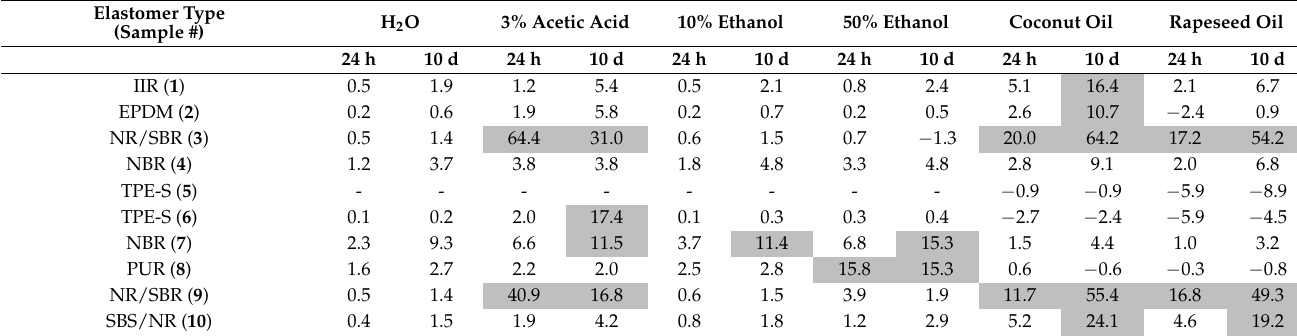
Table 4. Swelling of elastomer samples in food simulants in % as determined by weight gain after 24 h and 10 days of migration time. Weight changes exceeding 10% are highlighted in